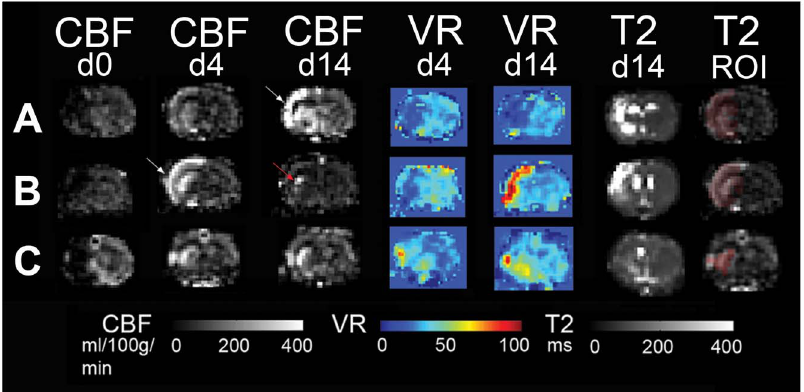
Figure 3. Patterns of hyperperfusion and changes in vasoreactivity. Three representative image series (slice IA 7.5 mm) from animals with A: large cortico-subcortical., B: moderate cortico-subcortical and C: predominantly subcortical infarction. CBF maps on days 0, 4 and 14; along with vasoreactivity (VR) - maps and T2 maps (from d4 and 14/d14) are shown. On the right, the masked infarct area as extracted from D14 T2 maps is overlaid onto the CBF D4 map to show the spatial overlap between hyperperfusion and final infarct. White arrow: points to maximum of hyperperfusion, which occurs at different time points in A) and B). Red arrow in B): when the amount of hyperperfusion has declined, remaining voxels with hyperperfusion are localized more to the infarct border.